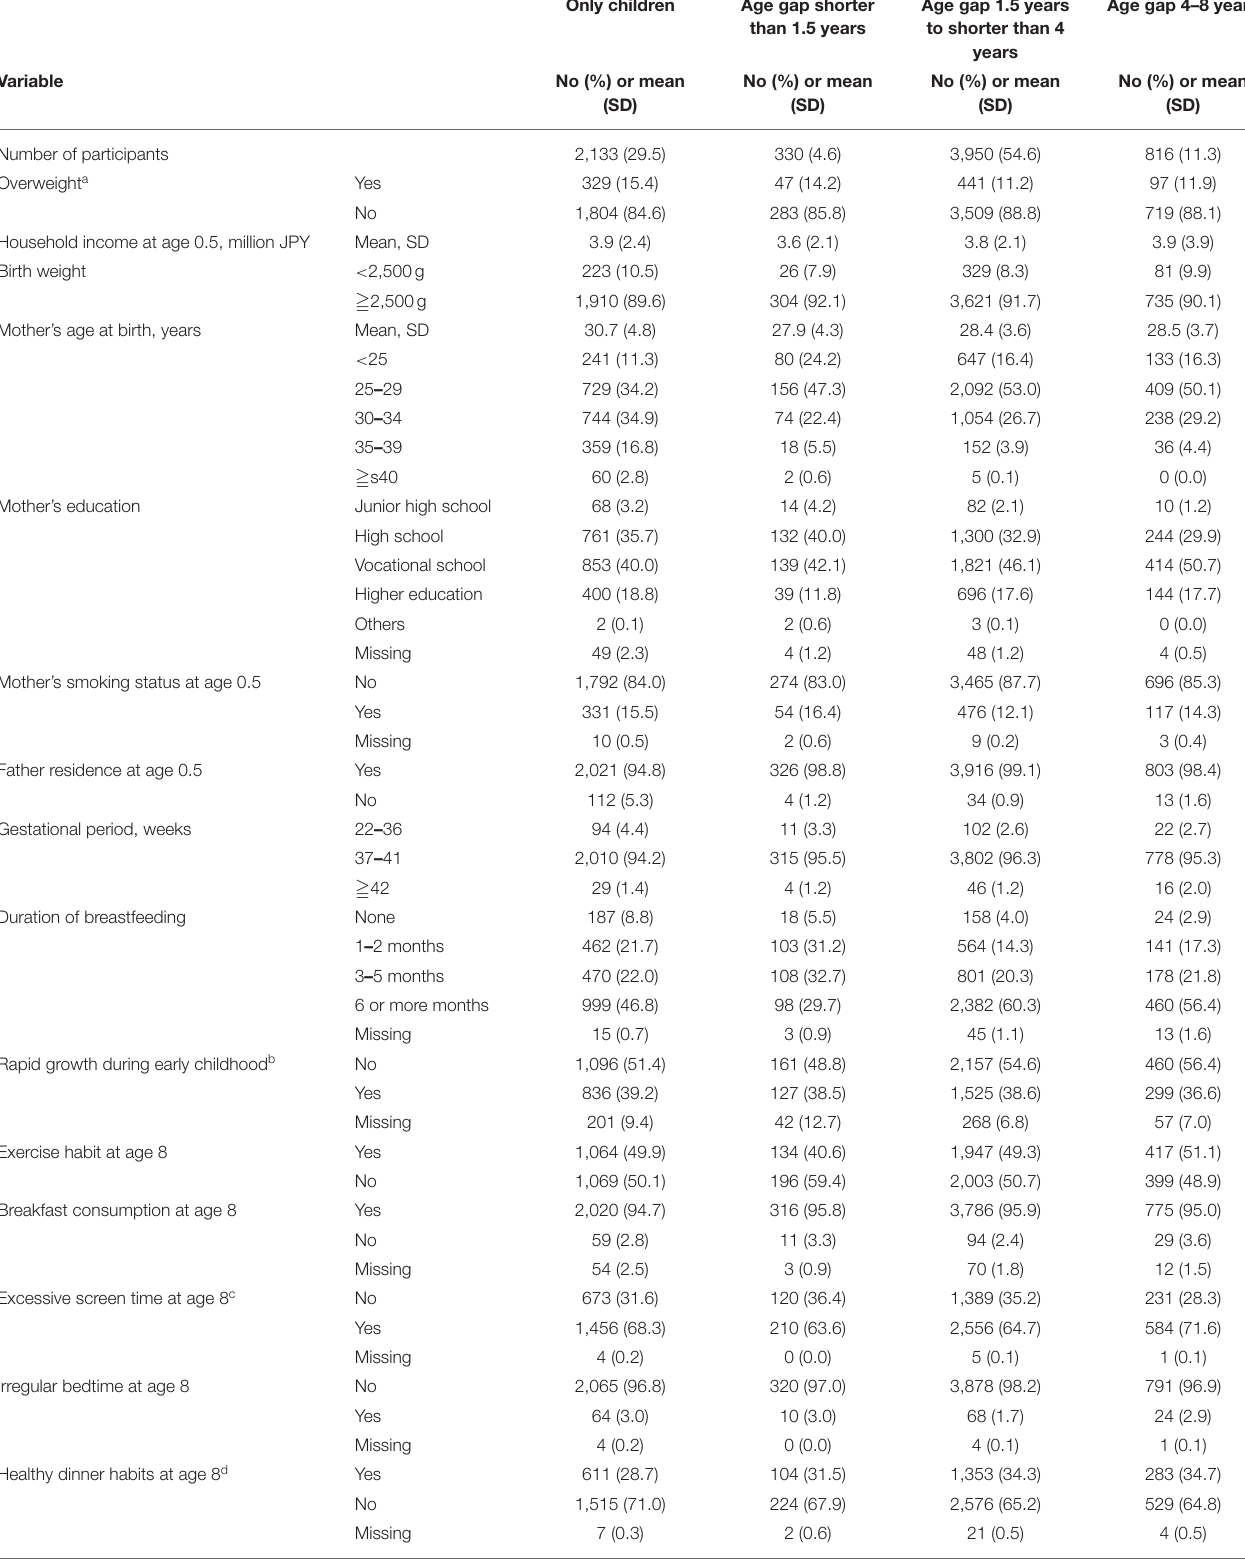
TABLE 3 | Characteristics of study participants from the Longitudinal Survey of Newborns in the 21st Century, 2001–2009 (girls n =